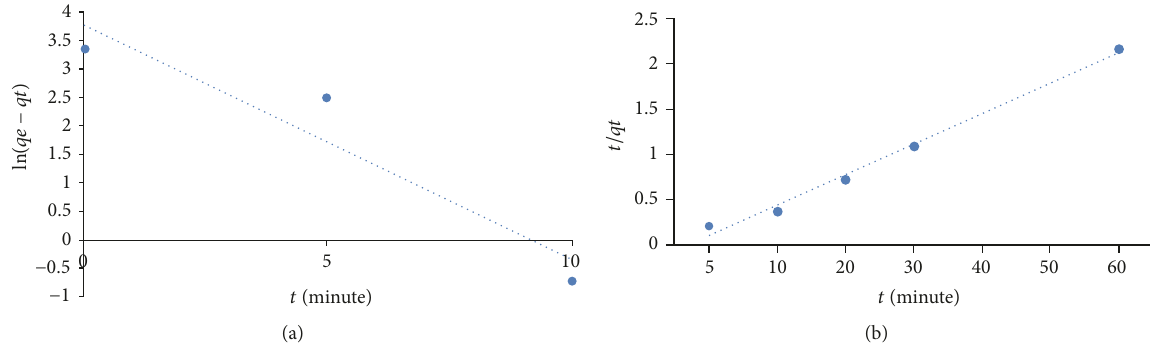
Figure 10: The adsorption kinetics of P(DEAMSt0.11-co-MMA): (a) first-order and (b) pseudo-second-order.